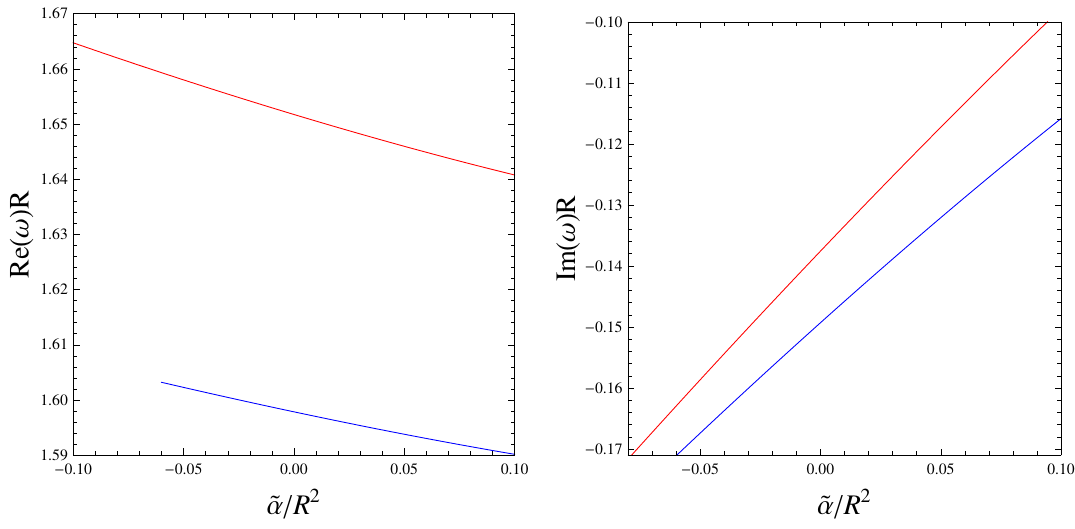
Figure 1 . Real (left panel) and imaginary (right panel) part of the fundamental scalar (sound) quasinormal modes for various values of r H =R = 6, ‘ = 2.